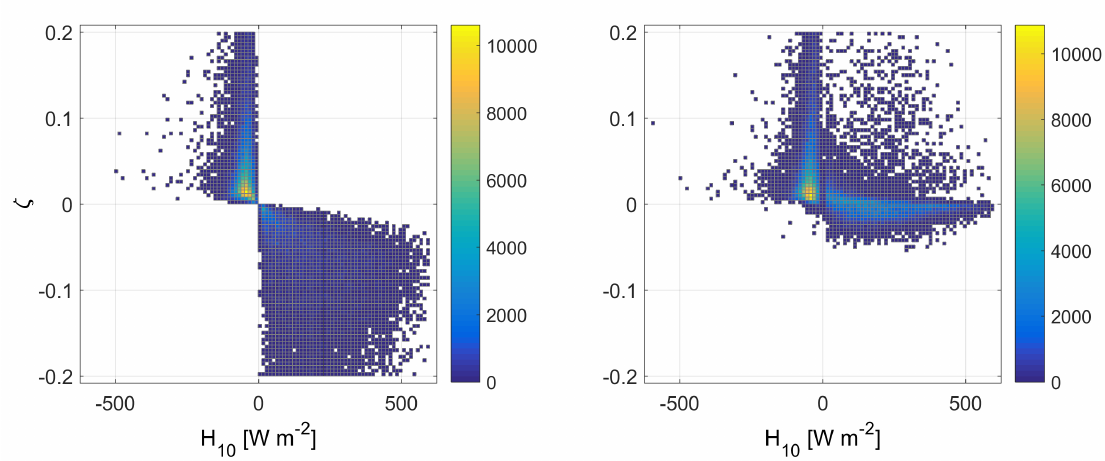
Figure 4. Comparison of the sensible heat fluxes obtained with MOST and Ri B ,